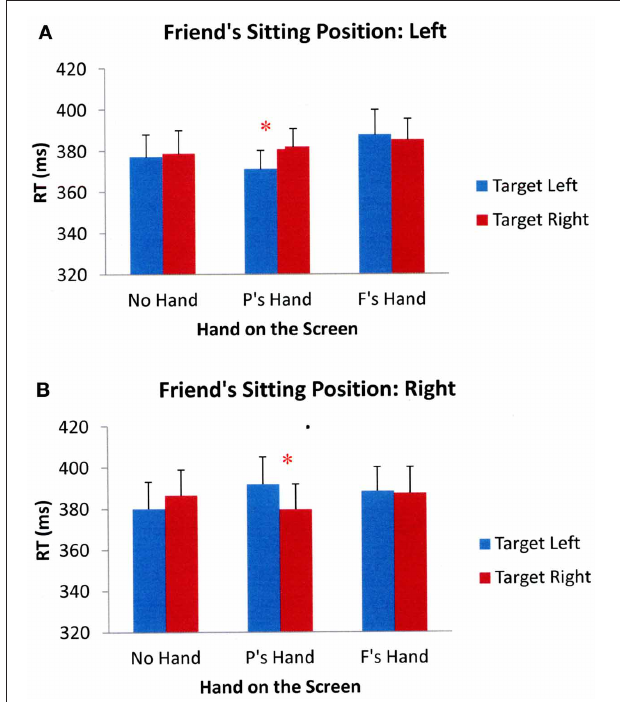
FIGURE 4 | Mean reaction times across all participants in different Experimental conditions of Experiment 2 when a friend was sitting to the participants’ left (A) and right (B). Error bars represent standard errors of the means. (Note: P’s = Participant’s; F’s = Friend’s). ∗ p < 0 .